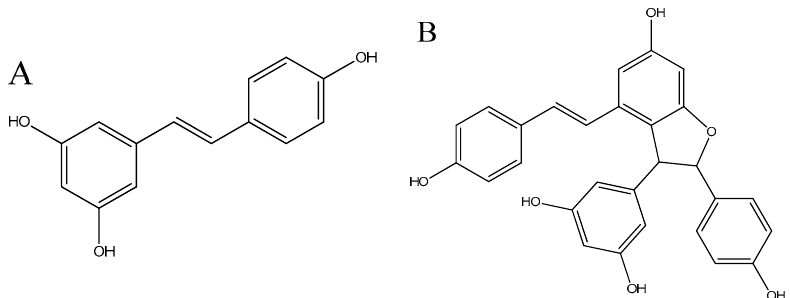
Figure 1. Chemical structure of trans-resveratrol ( A ) and trans- ε -viniferin ( B ) stilbenes.